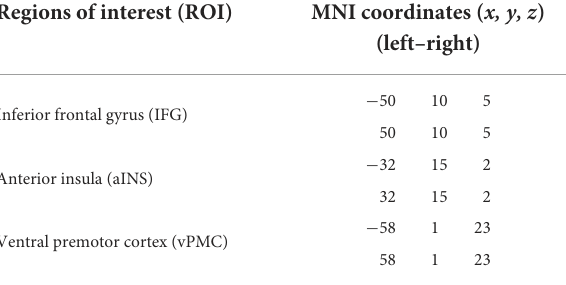
(left–right) − 50 10 5 50 10 5 − 32 15 2 32 15 2 − 58 1 23 58 1